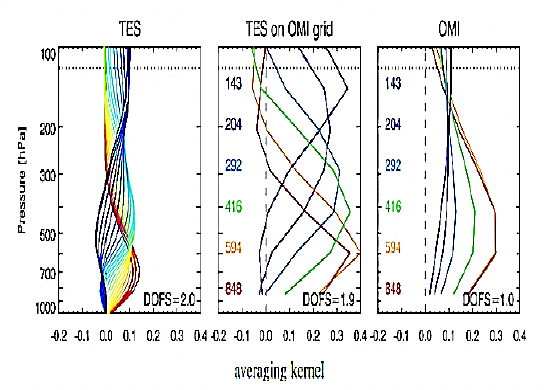
Figure 4- An example of the averaging kernel for extracted ozone from TES (left) and OMI (right) at altitudes lower than 100 hPa and in non-cloudy conditions (φ = 28N, λ = 58W). The dash in an altitude of about 120 hPa represents the boundary layer.